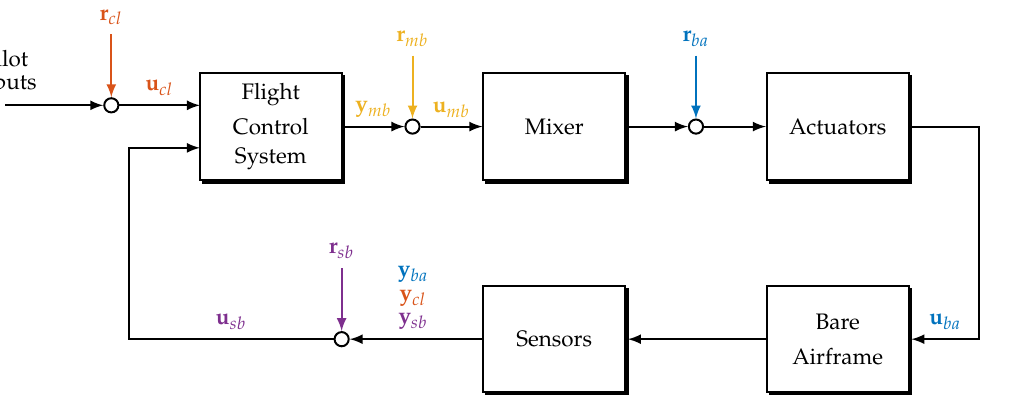
Figure 1. A block diagram of a generic flight control system showing the excitations r , inputs u , and outputs y for multiple loops.